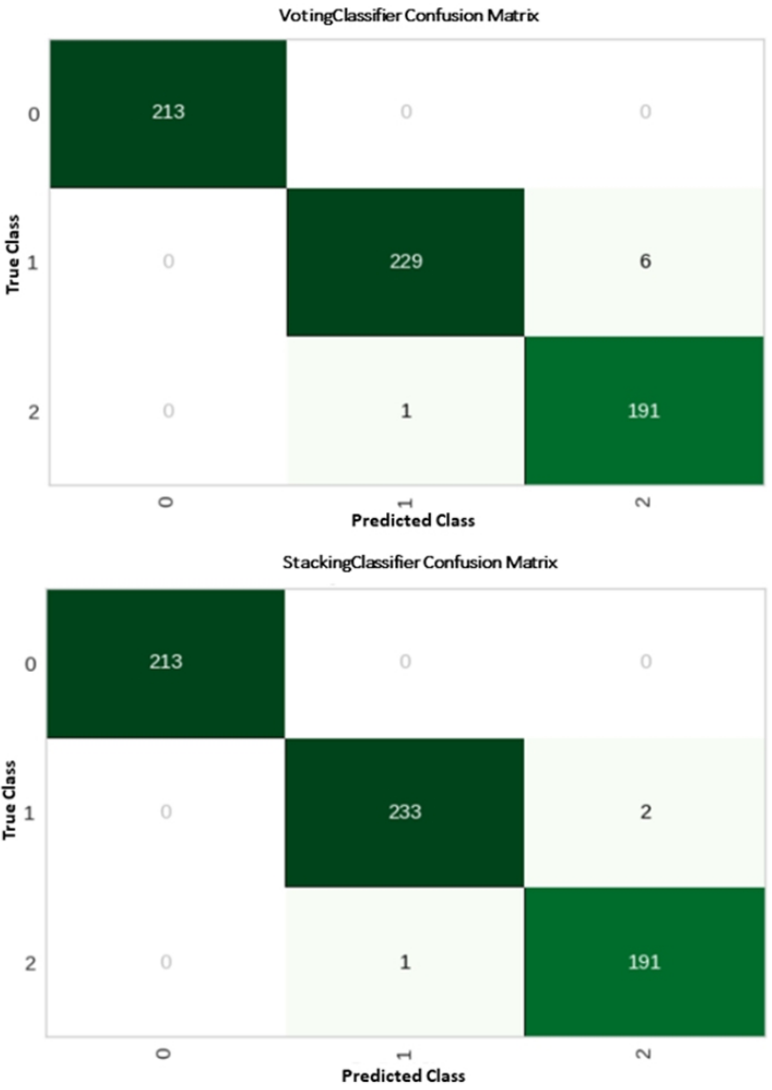
Figure 4. Confusion matrix for voting and stacking